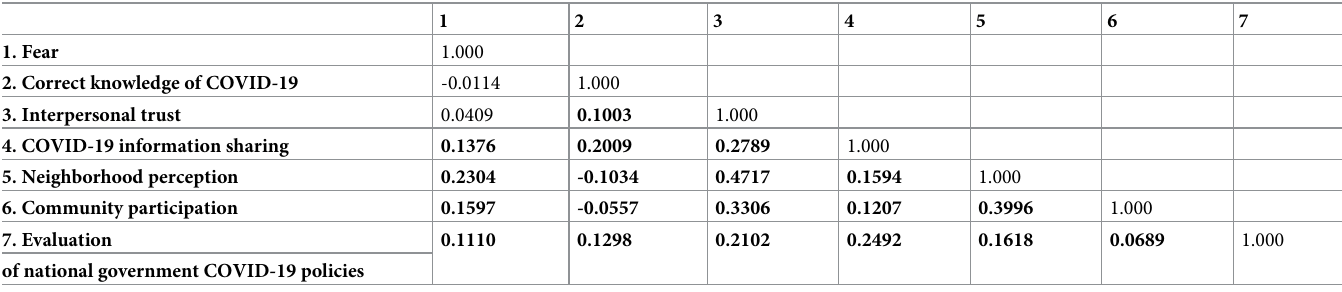
Table 2. Correlation matrix for multilevel factors (N =